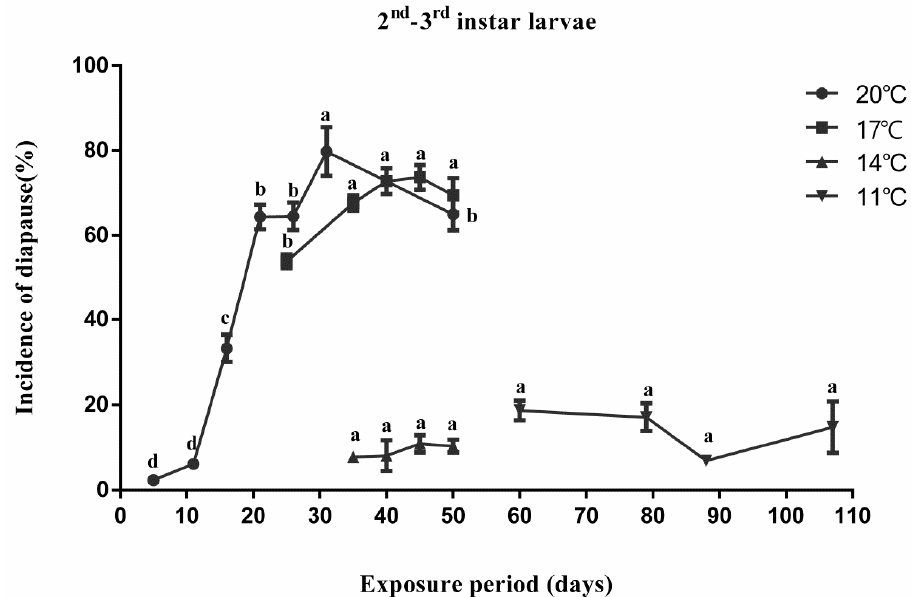
Figure 1. Effect of temperature and exposure period on diapause induction in Anastatus japonicus when 2nd–3rd instar larvae used as inducing initial stage (mean ± SE%). Different letters indicate significant difference (one-way ANOVA, followed by LSD multiple-comparison tests, p < 0.05) between different exposure periods at the same temperature.